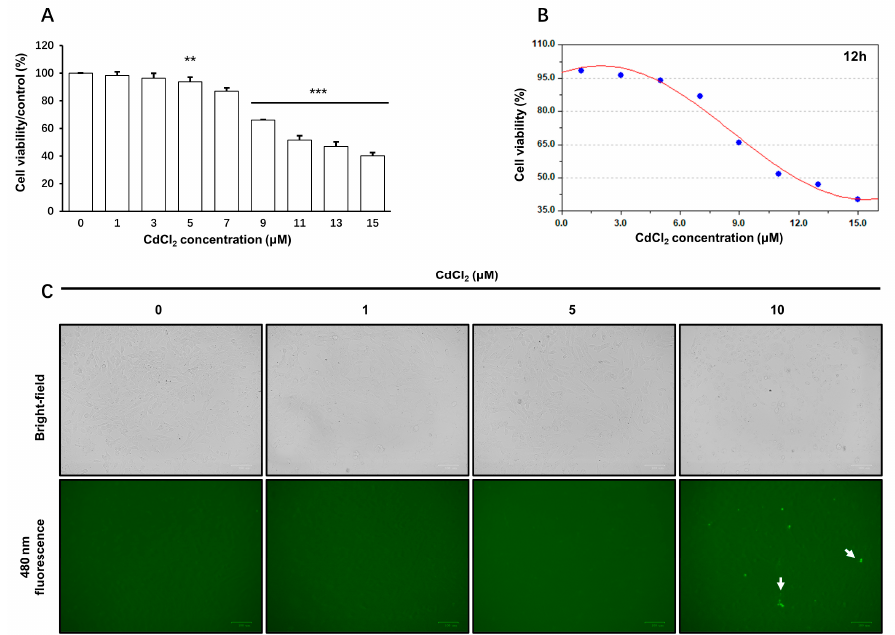
Figure 1. CdCl 2 treatment reduced cell viability and induced apoptosis in a dose-dependent manner. The cell viability was evaluated by using the CCK8 test in TM4 cells after incubation for 12 h, in the presence of CdCl 2 . Data were significantly different between CdCl 2 (5~15 µ M) treatment and controls as determined by using the t -test ( p < 0.01) ( A ). The inhibition effects of CdCl 2 were also estimated using the Sine Fitting algorithm, where an IC 50 was deduced as 11.8 µ M at 12h ( B ). The cellular apoptosis was detected with a TUNEL assay. Representative images illustrate the presence of TdT-mediated dUTP Nick-End Labeling (white arrow) showing DNA breaks during apoptosis ( C ). ** p < 0.01 compared to the control group, and *** p < 0.001 compared to the control group.